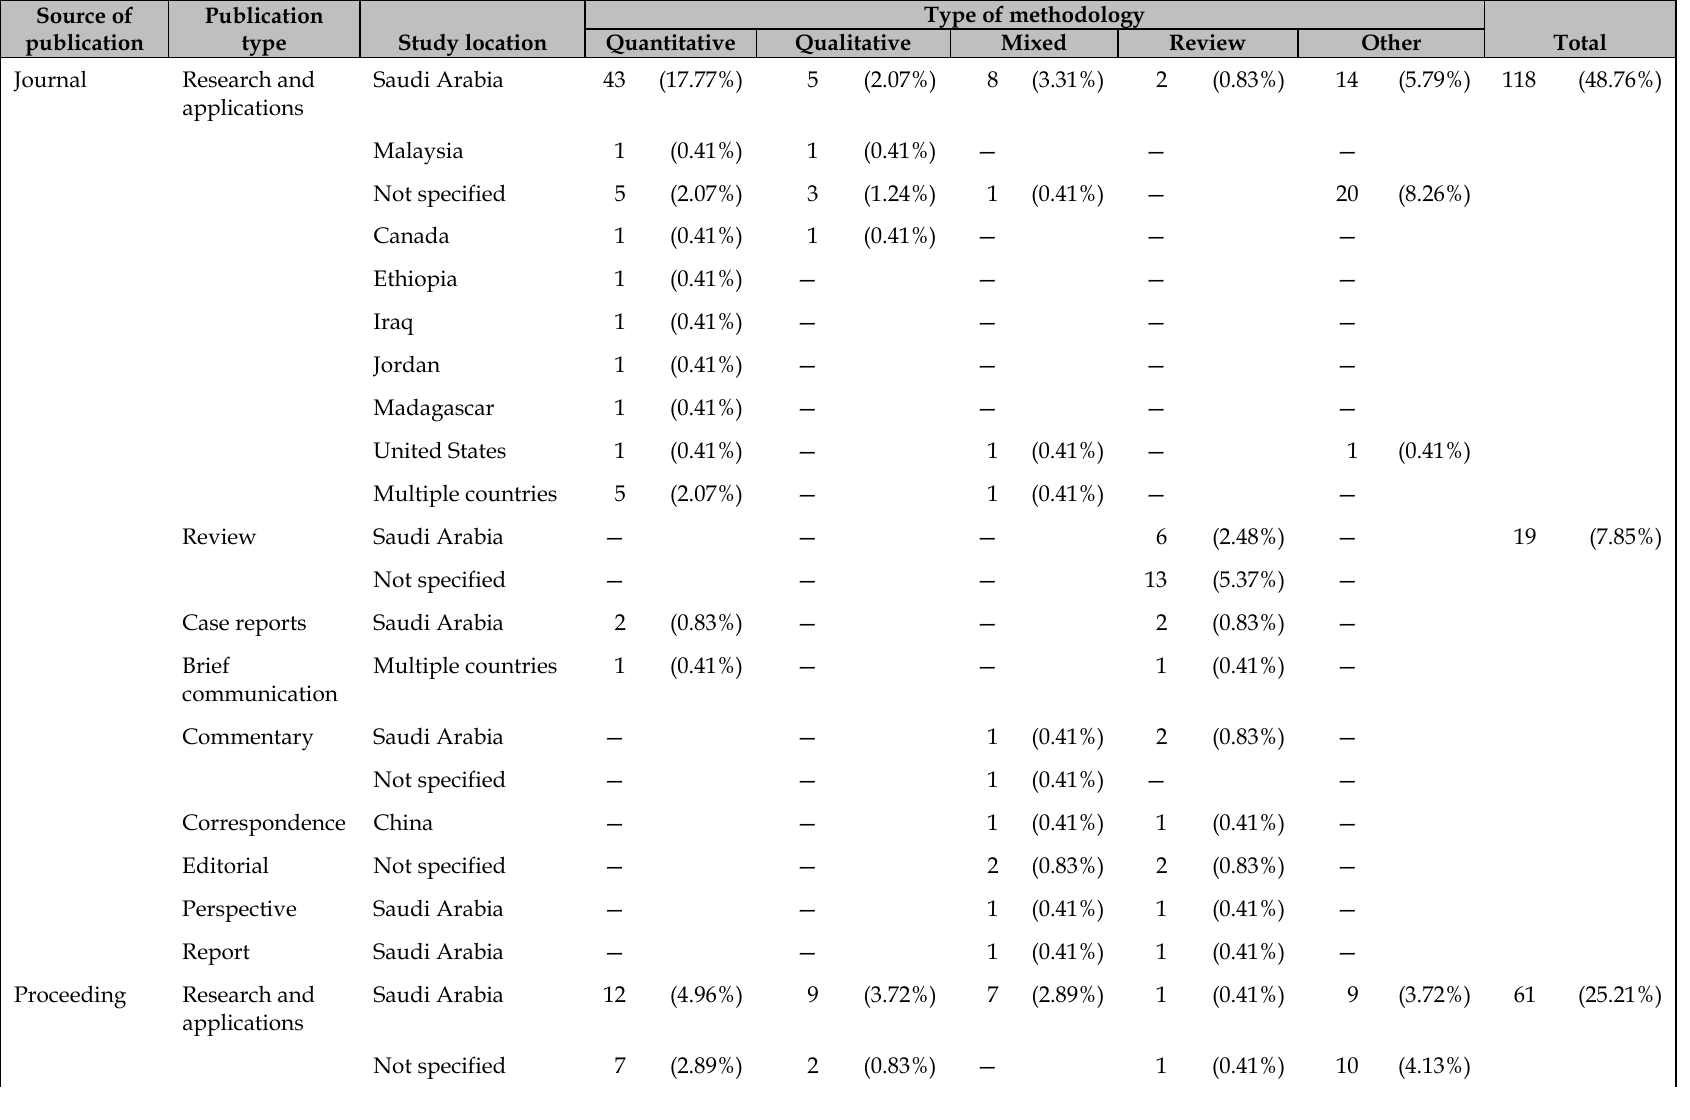
Table 1 A descriptive summary of health informatics (HI) publications by Saudi-affiliated